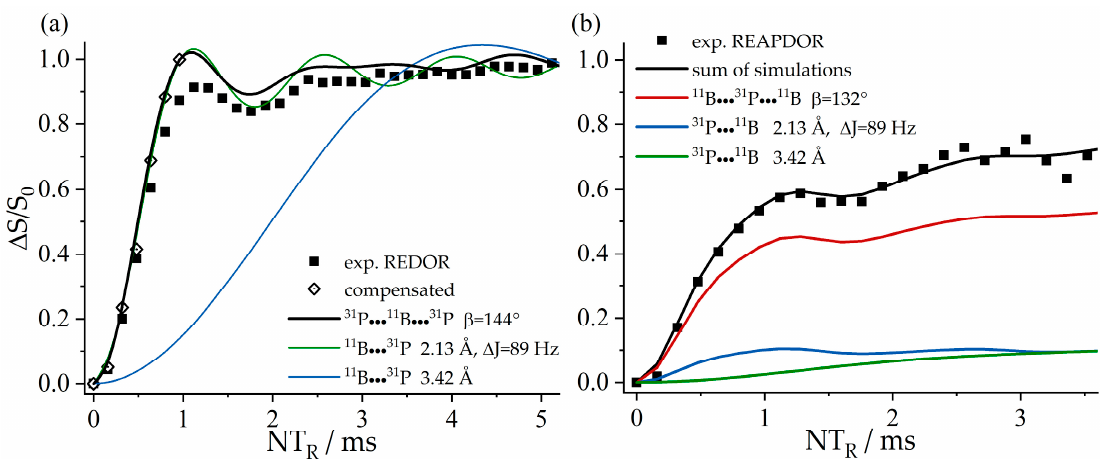
Figure 36. ( a ) Experimental and simulated 11 B{ 31 P} REDOR curves of 9 . Two-spin simulations based on the shortest intermolecular distance, including a calculated J- anisotropy of 89 Hz (green curve) and the intramolecular distance (blue curve). Black curve: Three-spin simulation based on the two closest boron–phosphorus distances in the specific dipolar geometry present in the crystal structure. ( b ) 31 P{ 11 B} REAPDOR curves for 9 showing simulations for the three distinct isotopologue contributions to the overall response (black) curve.